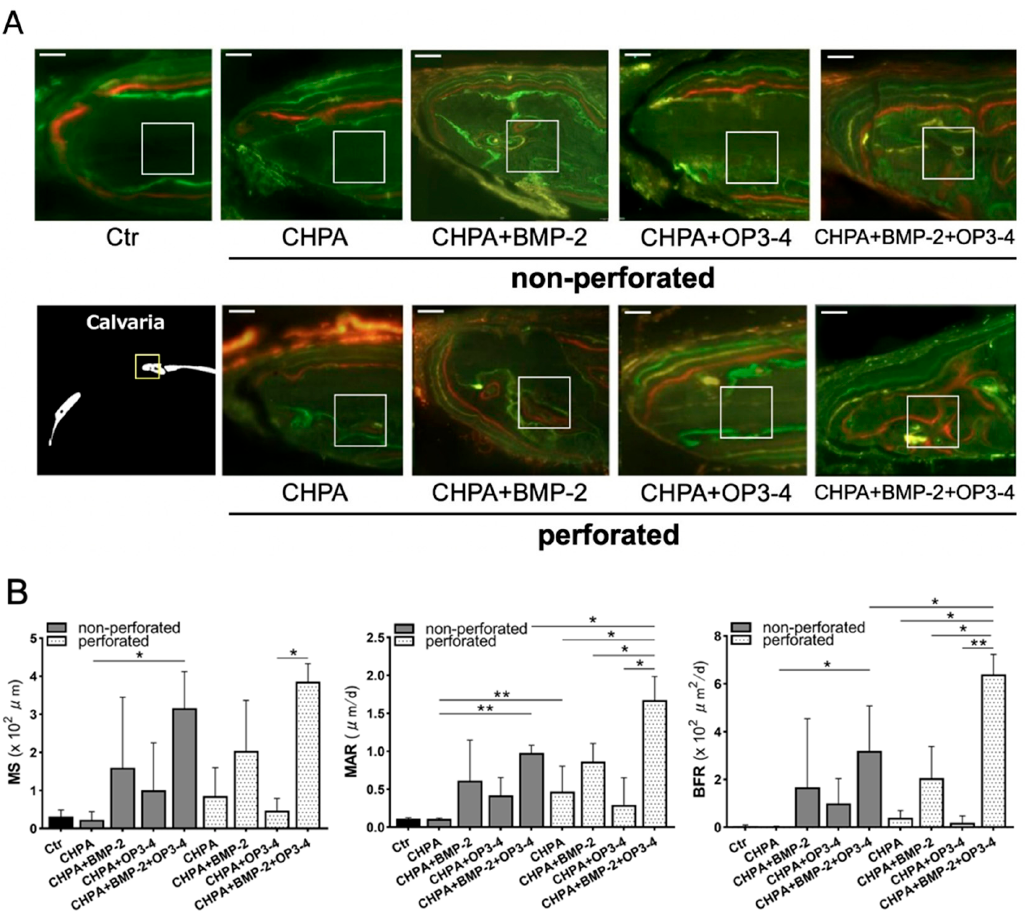
Figure 5. The perforated CHPA scaffold group showed higher bone formation in comparison to the nonperforated scaffold group: ( A ) Fluorescence micrographs of undecalcified sections at the bone edge of the defect site. The white 100- μ m square inset represents the ROI for measurement. Green fluorescence indicates calcein administered on days 8 and 32 before euthanization; red fluorescence, alizarin administered on day 24 before euthanization; and yellow fluorescence, demeclocycline administered on day 16 before euthanization. Scale bar = 50 µ m ( B ) Quantitative analyses of bone histomorphometry. Mineralizing surface (MS), mineral apposition rate (MAR), bone formation rate (BFR). Normality was analyzed by the Shapiro–Wilk test. Comparisons between groups were performed using the Wilcoxon rank sum test. Values are expressed as the mean ± SD, * p < 0.05, ** p < 0.01.